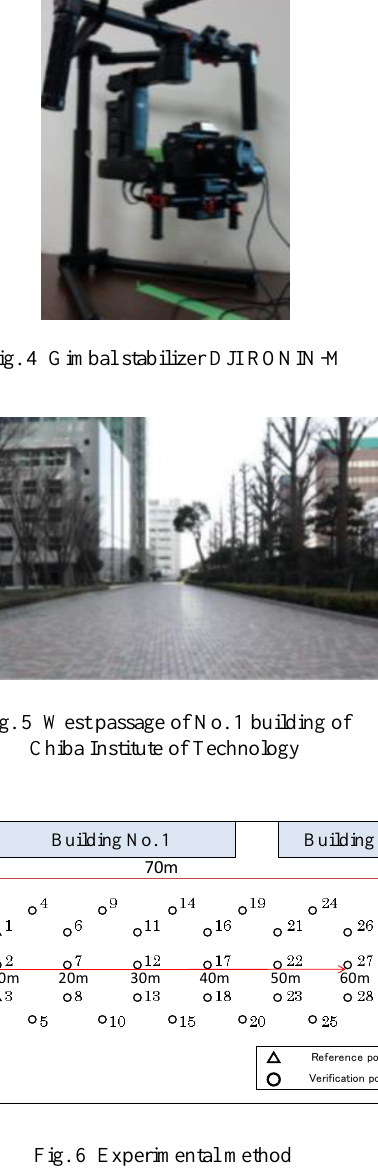
Fig. 6 Experimental method